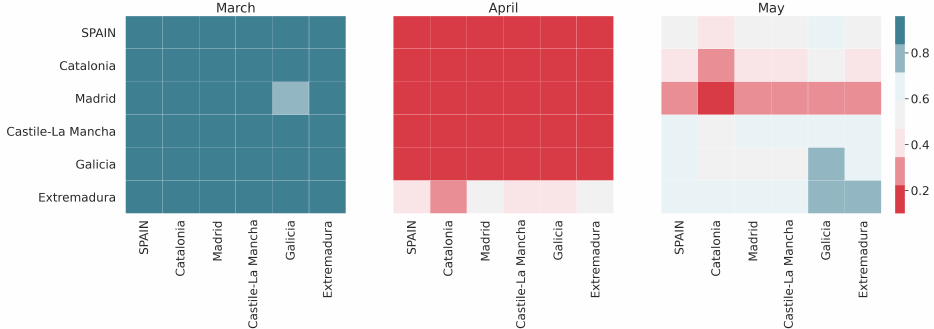
Figure 5. Pearson correlation between Facebook’s remain in tile and Google’s residential index for different regions and months. Facebook plotted on the horizontal axis, and Google on the vertical